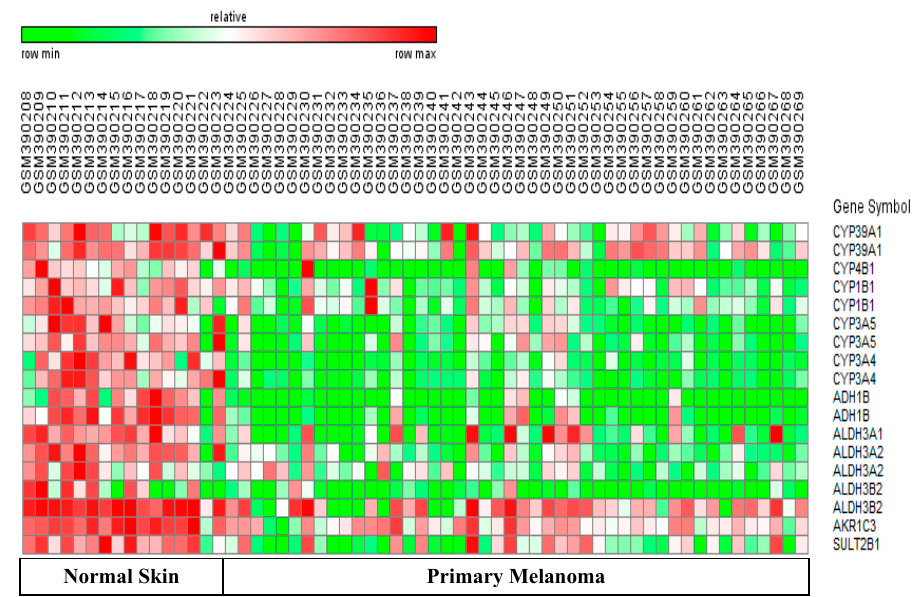
Figure 2. Heatmap of DEGs from GSE 15605. Melanomas showed downregulation of phase II genes controlling vitamin A degradation (AKR1C3), antioxidant defense (ALDH3A1, ALDH3A2, ALDH3B2, ADH1B), and cholesterol catabolism (CYP39A1). Genes metabolizing arachidonic acid (CYP4B1) and drugs (CYP4B1, CYP1B1, CYP3A5, and CYP3A4) were down-regulated in melanomas. Genes with high and low expression are rendered in red and green, respectively. Multiple entries for certain genes arise when different probe sets on the original array recognize an expressed